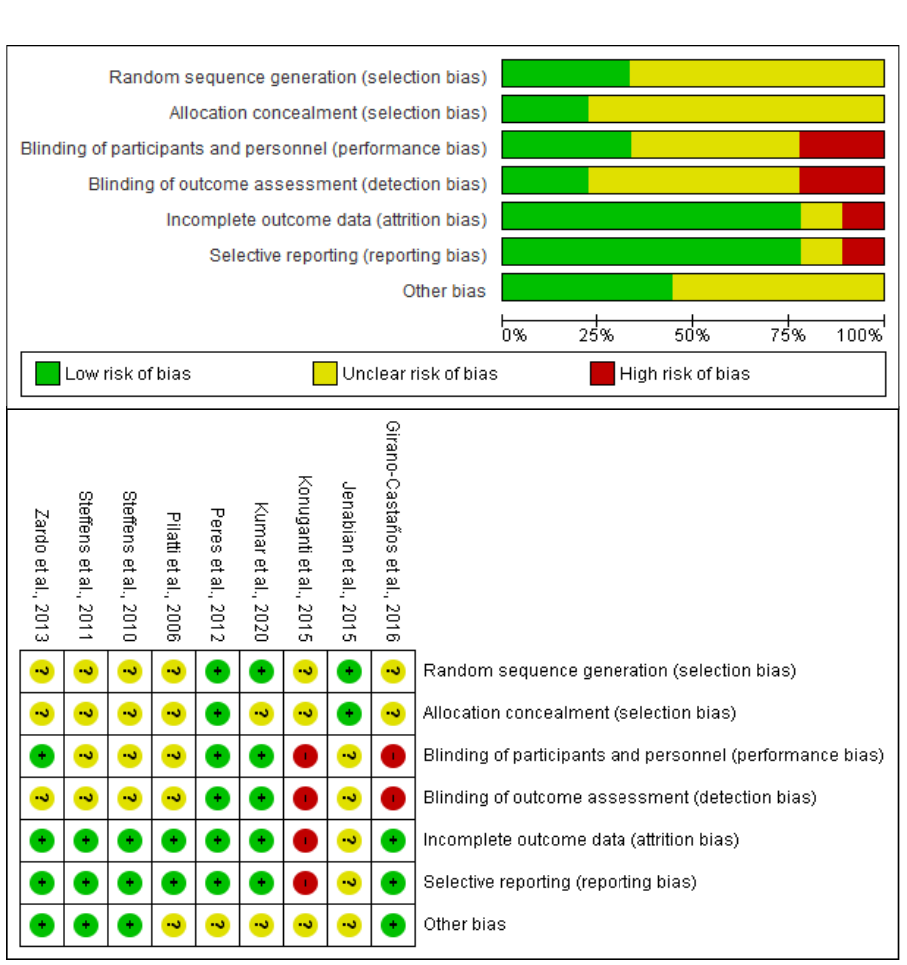
Figure 2. Evaluation of the risk of bias [22–30]. Table 1. Characteristics of the studies that met the selection